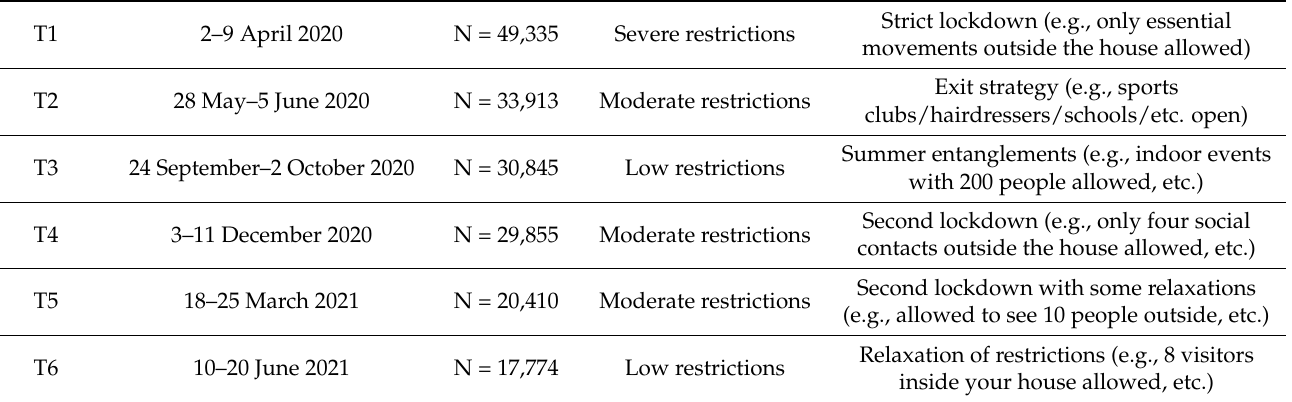
Table 1. Different time periods (1 to 6) of the COVID-19 survey, number of respondents, level of restrictions, and examples of implemented